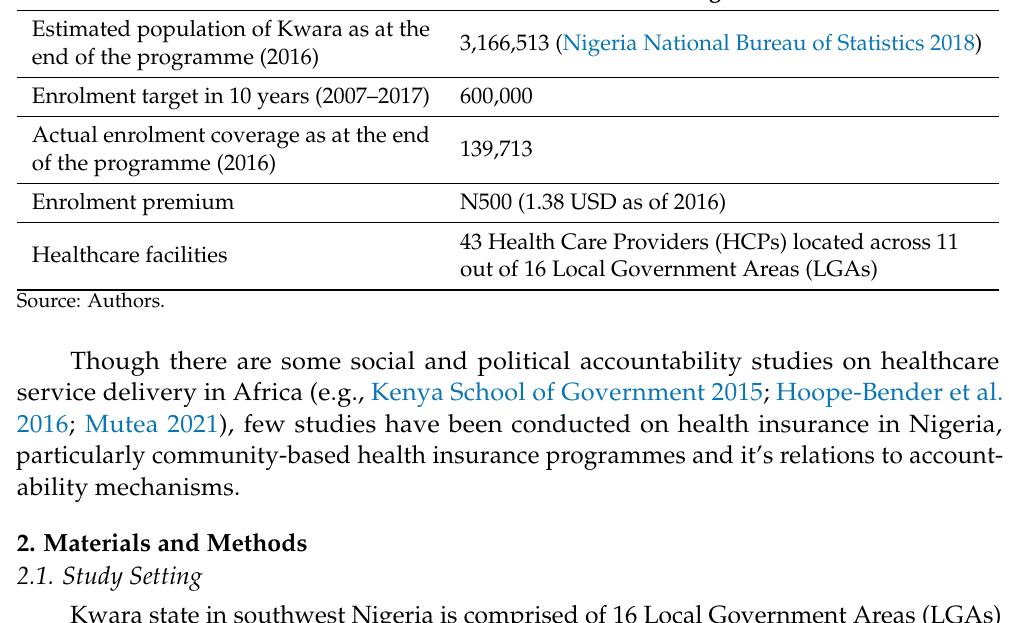
Table 1. Important Information about the CBHI Programme. Information Estimated population of Kwara as at